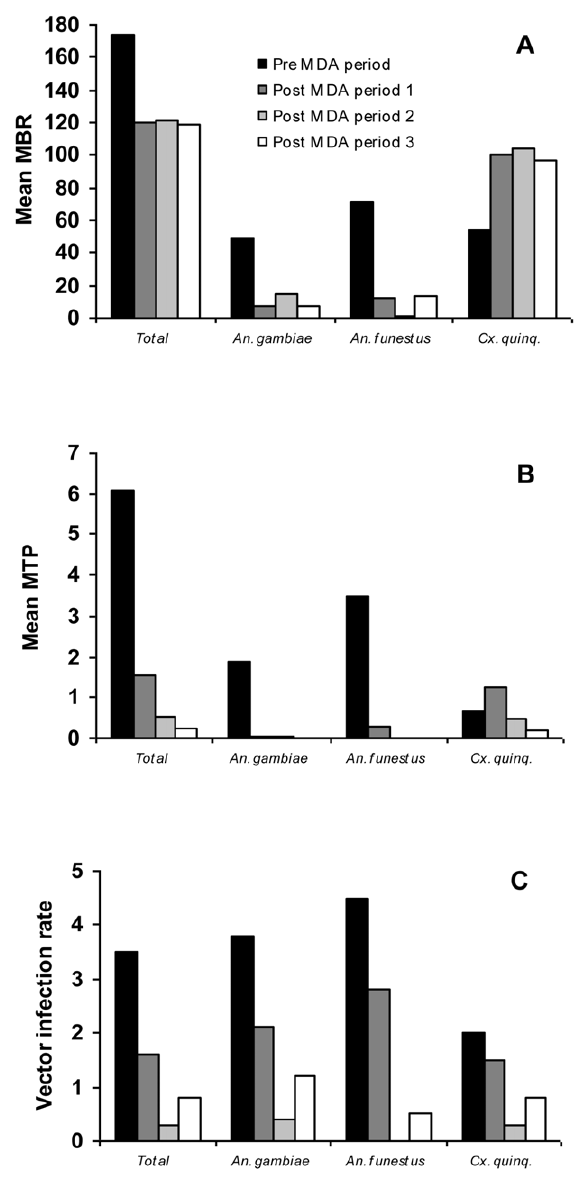
Figure 3. Mean monthly biting rate. (MBR; A), mean monthly transmission potential (MTP; B) and vector infection rate (C) in Kirare village during the pre-MDA period and the three post-MDA periods.